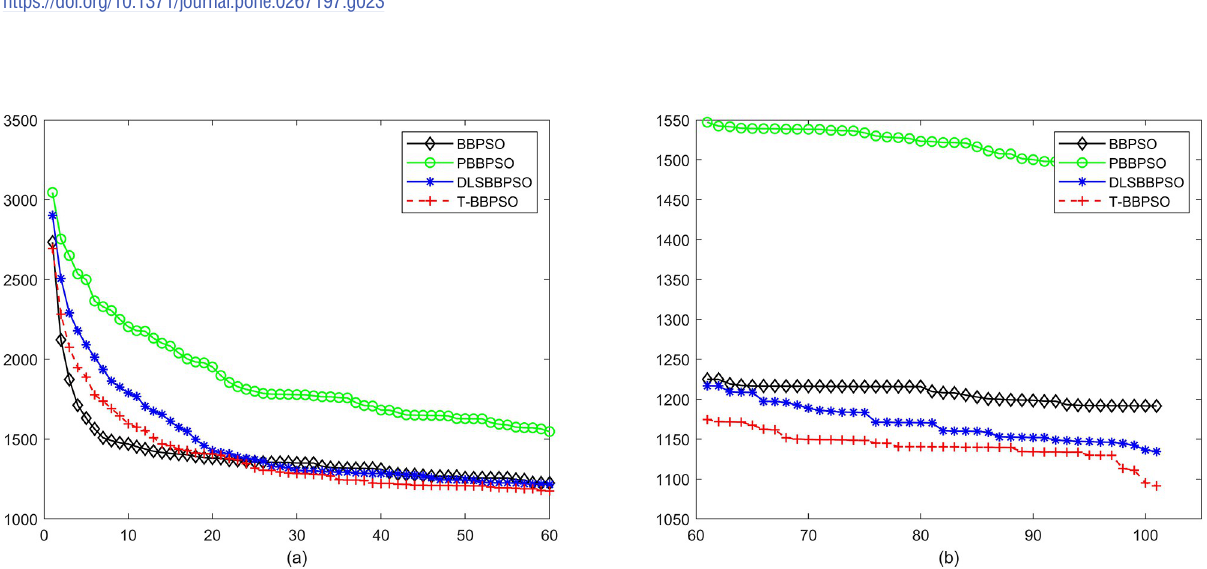
Fig 24. Comparison of convergence speed between BBPSO, PBBPSO, DLS-BBPSO and TBBPSO, f 22 , (a) iteration 0–6000, (b) iteration 6000–10000 the unit is 100 iteration.